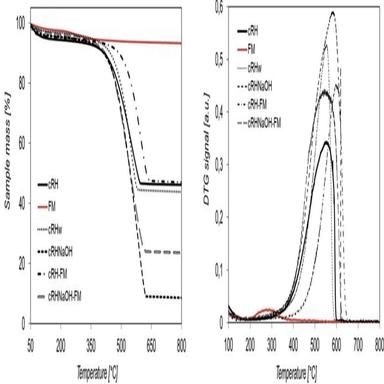
TG profiles (a) and the corresponding DTG curves (b) of analyses performed under oxidative atmosphere (synthetic air, 40 mL/min) up to 800◦C applying a heating rate of 10 ◦C/min.